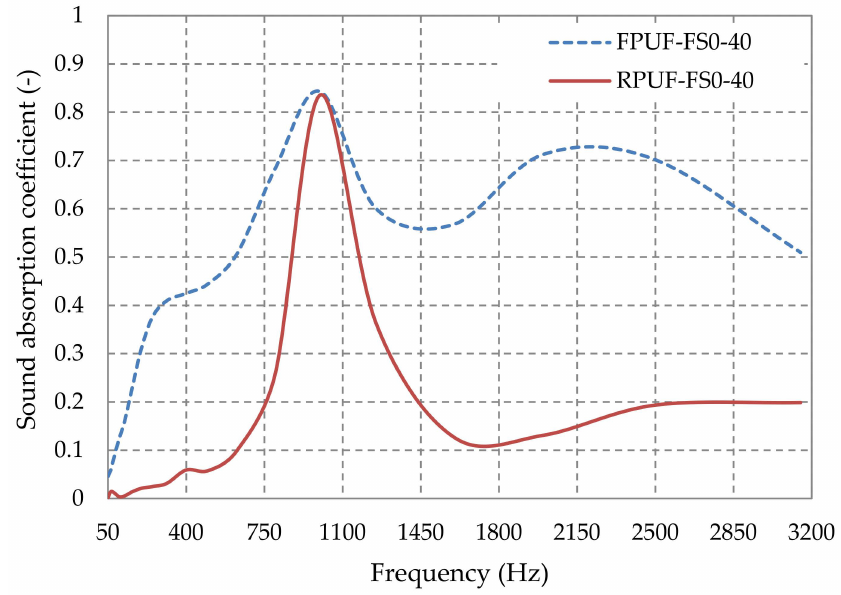
Figure 11. Sound-absorption coefficient variation with the type of polyurethane